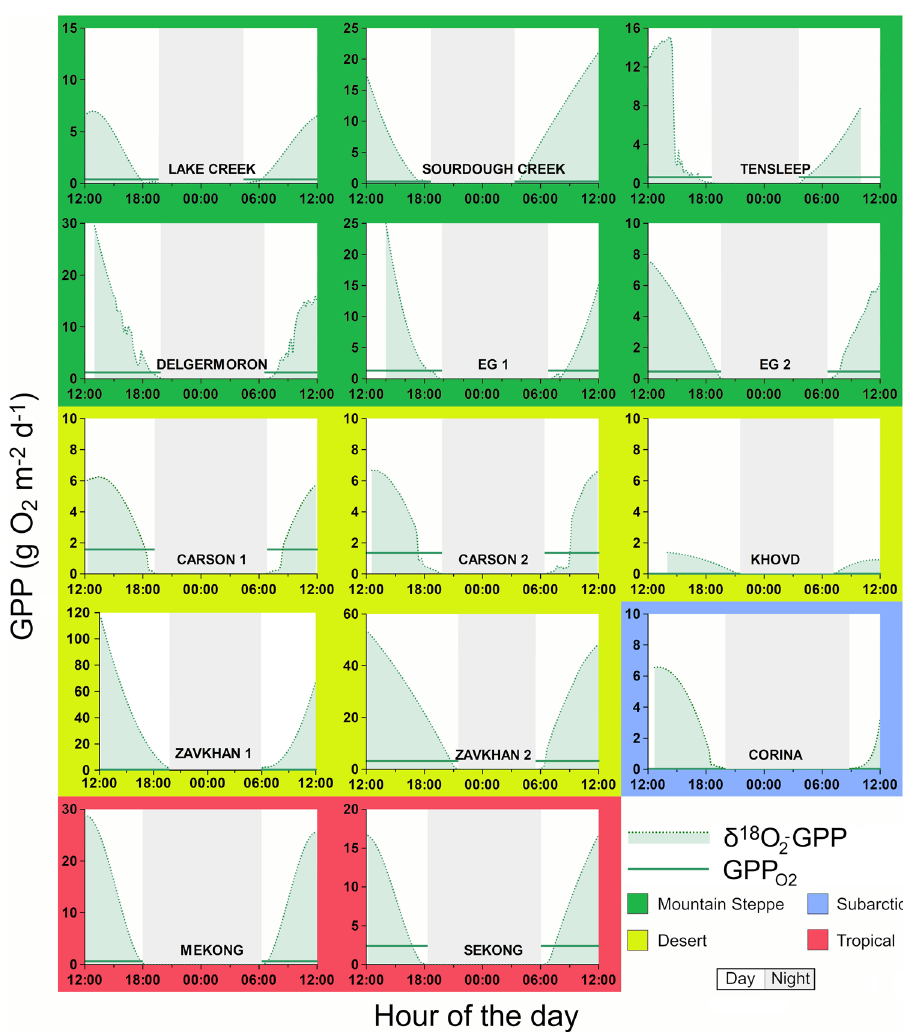
Fig. 3 Diel rates of gross primary production δ 18 O 2 -GPP from dual δ 18 O 2 and O 2 model. Gross primary production (GPP) in rivers estimated as diel δ 18 O δ 18 O – only model). Green panels represent mountain steppe 2 -GPP (green shading from dual 2 and O 2 model) compared to GPP O2 (green line from O 2 sites, yellow panels desert sites, and red panels tropical sites. The gray shading represents night